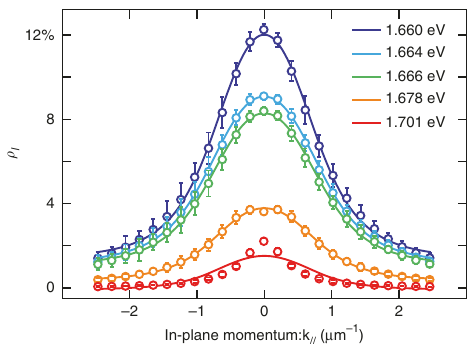
Fig. 4 Angular dependence of polariton valley coherence. Valley coherence ρ l at different pump energies are shown as a function of in-plane momentum. Solid lines are fi tting results. Errorbars represent the standard deviation among